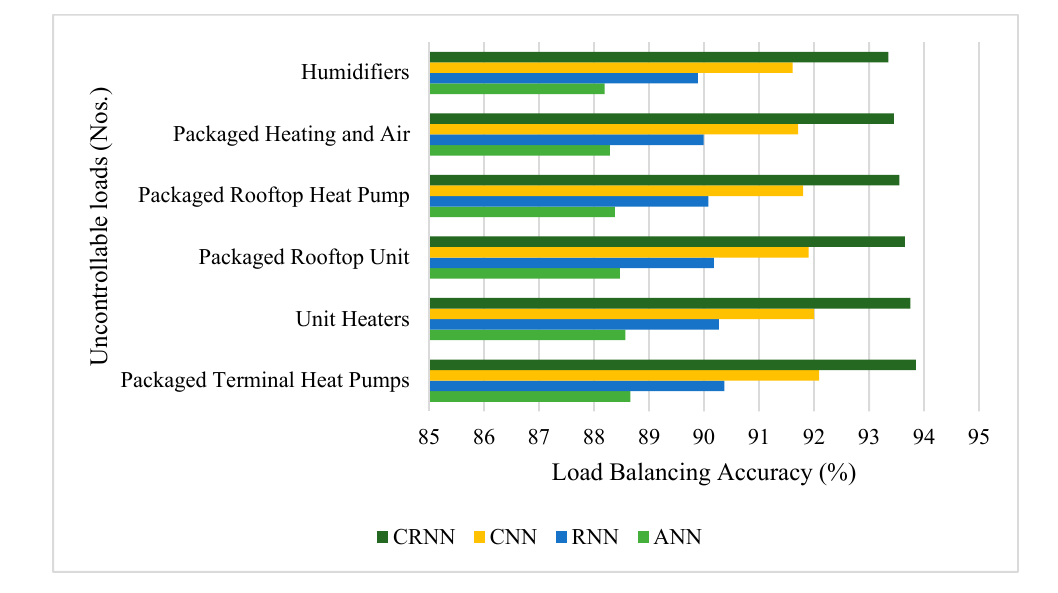
Figure 9. Load balancing accuracy (%) with more smart buildings.